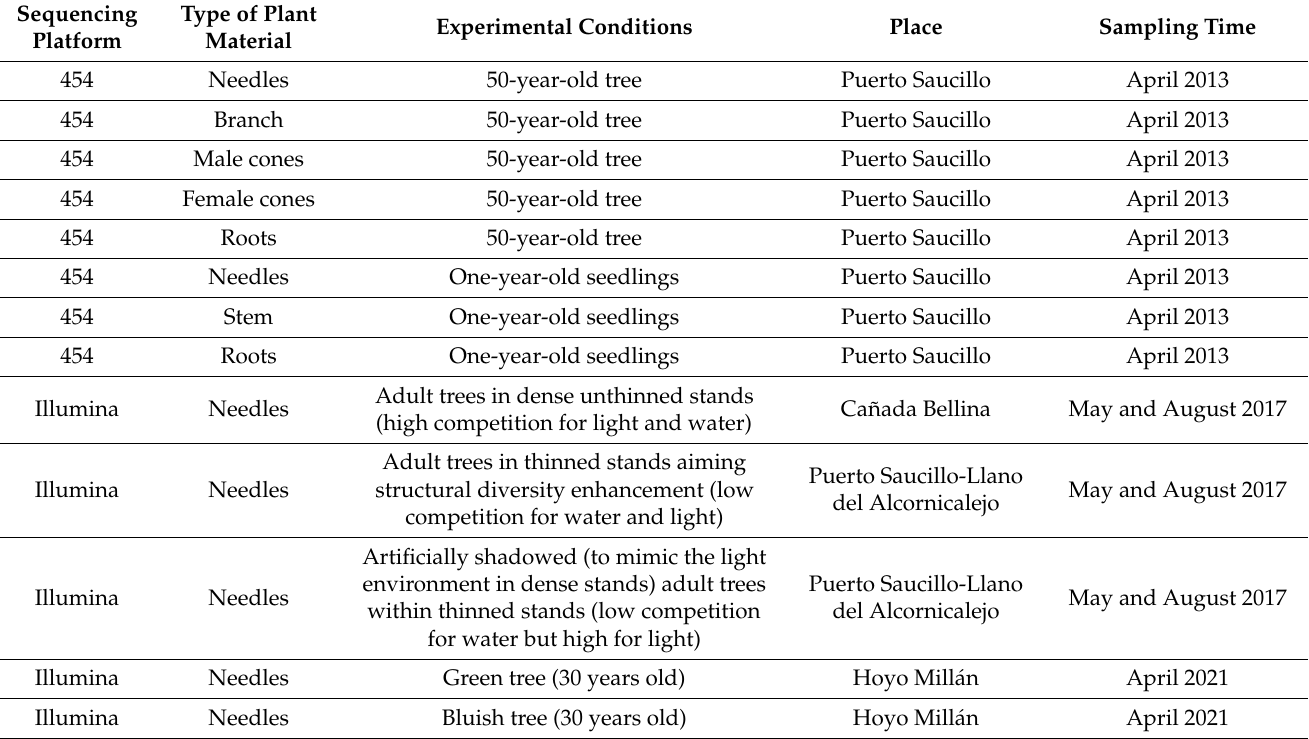
Table 1. Description of plant material used for transcriptome